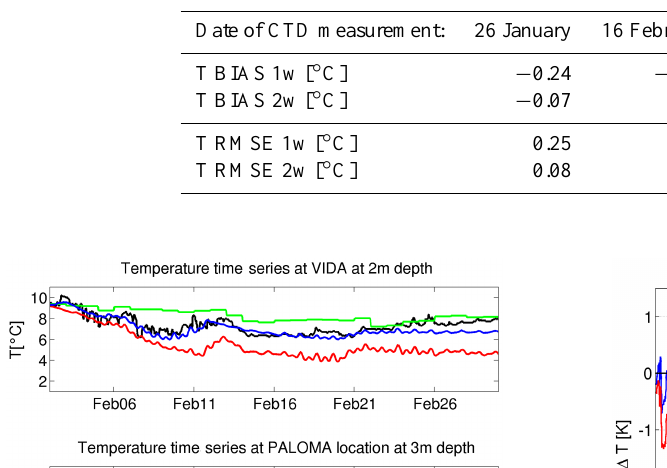
Table 3. Biases and root mean square errors (RMSE) [ ◦ C] between modeled POM1w, POM2w ocean temperatures and CTD observations at Vida location on four different dates before and after the 2012 bora outbreak.